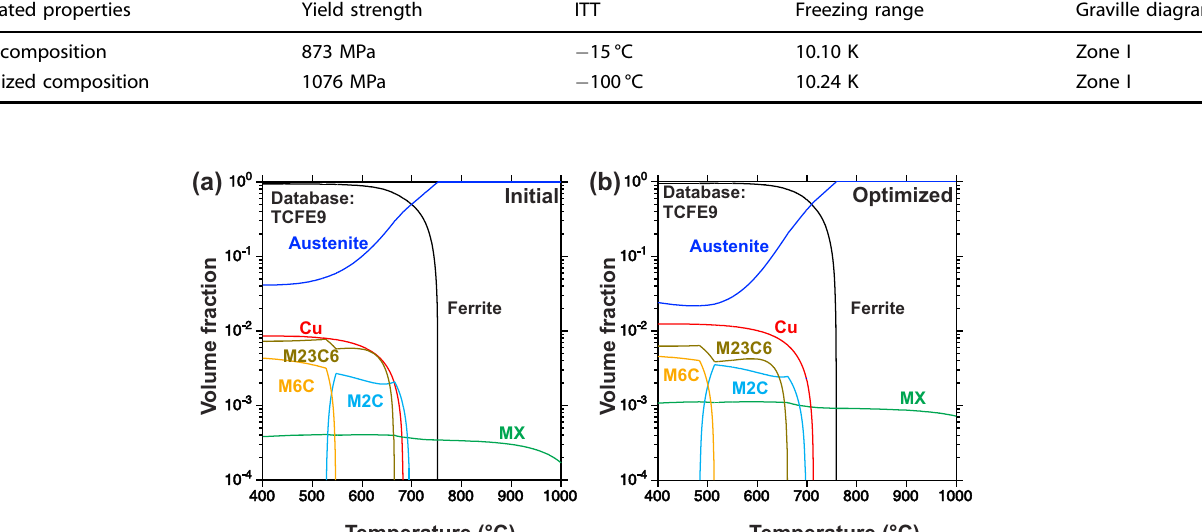
Table 4. Comparison of model-predicted key properties of the initial and optimized nominal compositions. Calculated properties